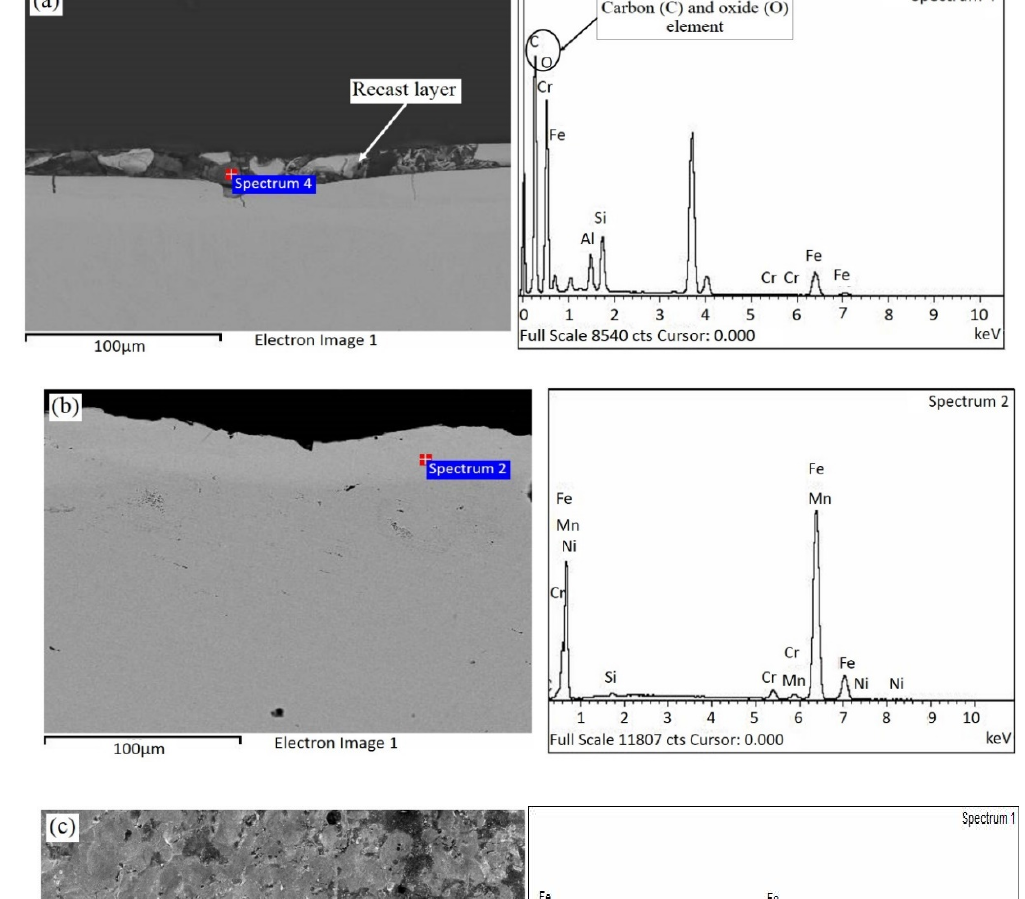
18 of 23 Figure 12. Craters and secondary sparks on the electrode: ( a ) EDM with side flushing, ( b ) EDM with multi-aperture flush- ing. 3.7. Surface Characteristics of EDM Deep Holes Figure 13a,b shows the cross-sectional SEM images of macro deep holes at 30 mm machining depth using EDM with side flushing and multi-aperture flushing. Figure 13c,d illustrates the deep hole surface of EDM with side flushing and multi-aperture flushing. In Figure 13a, a recast layer was formed on the workpiece machined with side flush- ing. The recast layer was the deposition and re-settlement of melted material from the workpiece and electrode and carbon from the dielectric fluid [38]. The EDS compositional analysis showed the presence of carbon (46.31% w/w ) and oxide elements (44.66% w / w ) in great quantity, as shown in Table 14. The carbon and oxide elements induced the for- mation of a recast layer on the workpiece. Micro cracks were observed in the workpiece underneath the recast layer. The cracks were primarily attributable to the differential ther- mal contraction between the higher-temperature recast layer and lower-temperature workpiece [39]. In Figure 13b, no recast layer was detected on the workpiece machined with EDM with multi-aperture flushing. The carbon and ferrous elements were 18.73 and 76.58% w/w without the oxide element, indicating the absence of a recast layer (Table 14). The melted material and debris were efficiently removed with multi-aperture flushing, thereby minimizing re-solidification. The incidence of recast layer formation on the work- piece was substantially reduced with multi-aperture flushing. Nevertheless, micro cracks with shallow penetration depths were observed on the workpiece surface (Figure 13d). In Figure 13c, the recast layer, melted drops, and spark craters were formed on the workpiece surface. The workpiece surface appeared smooth, as the recast layer mostly concealed the spark craters. In Figure 13d, the micro cracks with shallow penetration depths were observed on the workpiece surface. The shallow micro cracks were attribut-